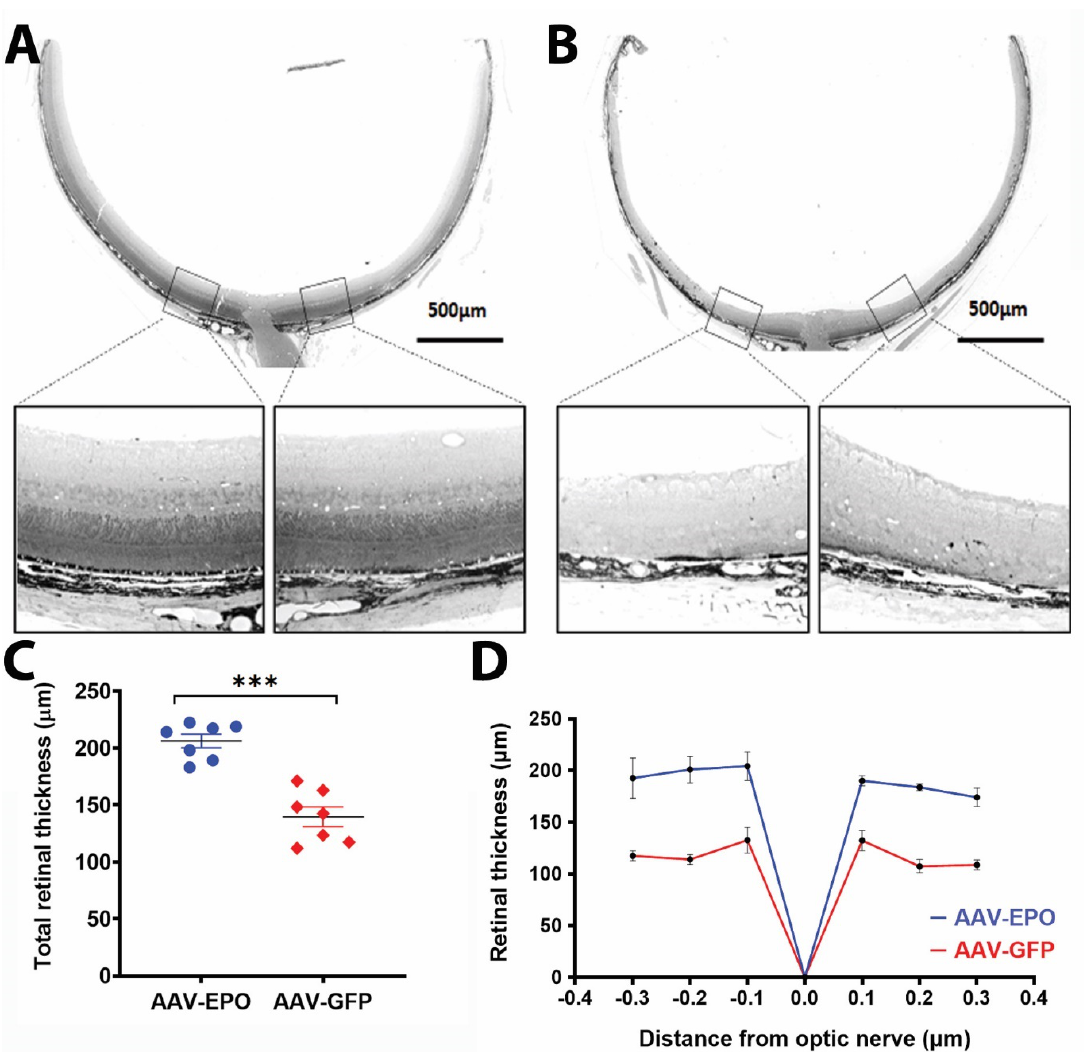
Figure 4. Preservation of retinal thickness: Representative low magnification and merged images of retina sections from treated ( A ) and untreated ( B ) eyes of one mouse through optic nerve and approximate areas (boxed and zoomed). ( C ) represents the measurement of the average of retinal thickness of eyes treated with AAV-EPO compared to AAV-GFP injected eyes. Spider graphs ( D ) of average retinal thickness at different distances from the optic nerve head ( n = 7) demonstrated that AAV-EPO treatment reduced degeneration of the retina. Scale bar 500 µ m. *** p ≤